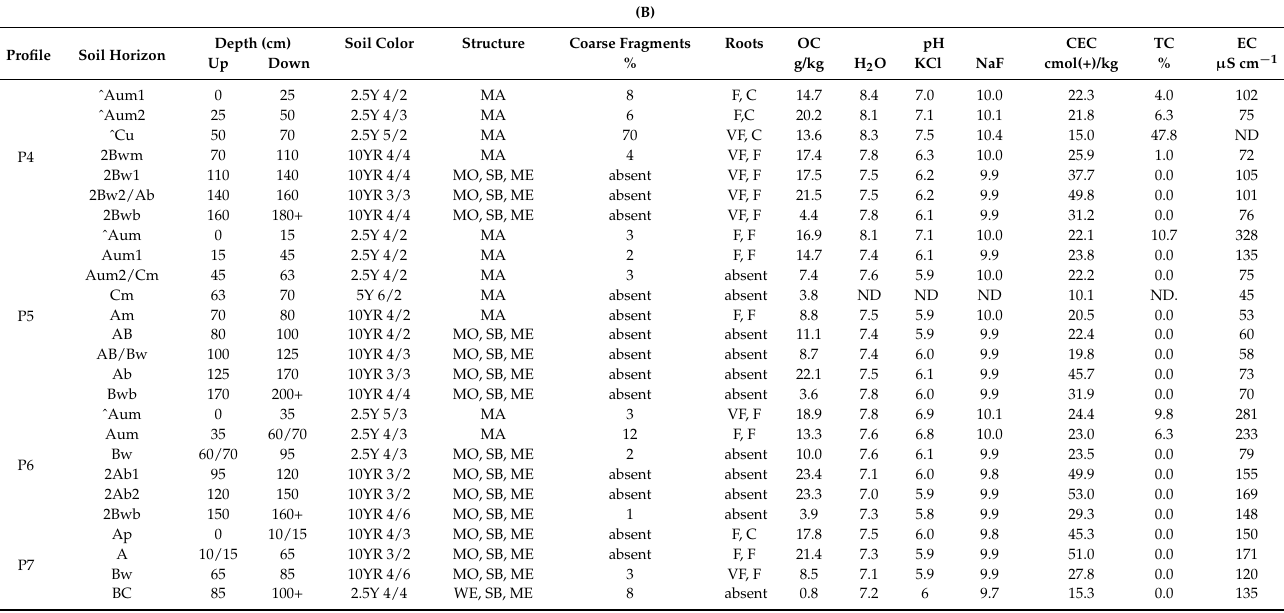
Legend: color: 2.5Y 4/2 = dark grayish brown; 2.5Y 4/3 and 4/4 = olive brown; 2.5Y 5/2 = grayish brown; 2.5Y 5/3 = light olive brown; 10YR 3/2 = very dark grayish brown; 10YR 3/3 = dark brown; 10YR 4/3 = brown; 10YR 4/4 and 4/6 = dark yellowish brown; 5Y 3/2 = dark olive gray; 5Y 4/2 = olive gray; 5Y 4/4, 5/3 and 5/4 = olive; structure: degree of development: WE = weak, MO = moderate; types: MA = massive, SG = single grain, AB = angular blocky, SB = subangular blocky, PR = prismatic, GR = granular, PL = platy, CR = crumbly; size classes (mm) for blocky/crumbly/lumpy/cloddys: VF = very fine/thin < 5, FI = fine/thin 5–10, ME = medium 10–20, CO = coarse/thick 20–50, VC = very coarse/thick > 50; roots: diameter (mm): VF = very fine < 0.5, F = fine 0.5–2, M = medium 2–5, C = coarse > 5; abundance (number): N = none 0, V = very few = 1–20, F = few 20–50, C = common 50–20, M = many > 200; OC = organic carbon, CEC = cation exchange capacity; TC = total carbonates; EC = electrical conductivity. Table 4. ( A , B ) Data of selected PTEs content (mg/kg), measured using the pXRF technique in situ, on soil profiles. Underlined: reported data exceeding CSC for residential/recreational land use (CSC1). Italics: values exceeding CSC for agricultural land use (CSC2). Bold: values exceeding CSC for commercial/industrial land use (CSC3). For As, recalculated values based on Caporale et al., 2018 are reported in brackets. ND = not determined. The caret symbol (ˆ) is used as a prefix to indicate horizons and layers formed in human-transported material.